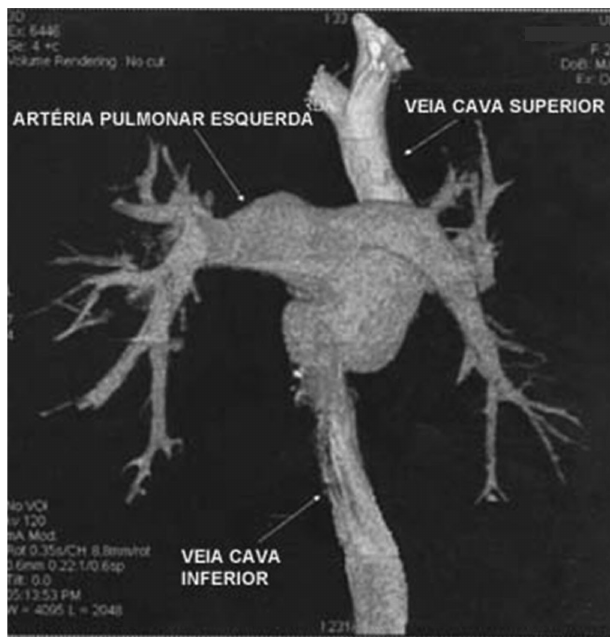
Fig. 2 - CT angiography (posterior view) showing total cavopulmonary connection with wide side-to-side anastomosis between the superior vena cava (vena cava superior) and dextroposed pulmonary artery